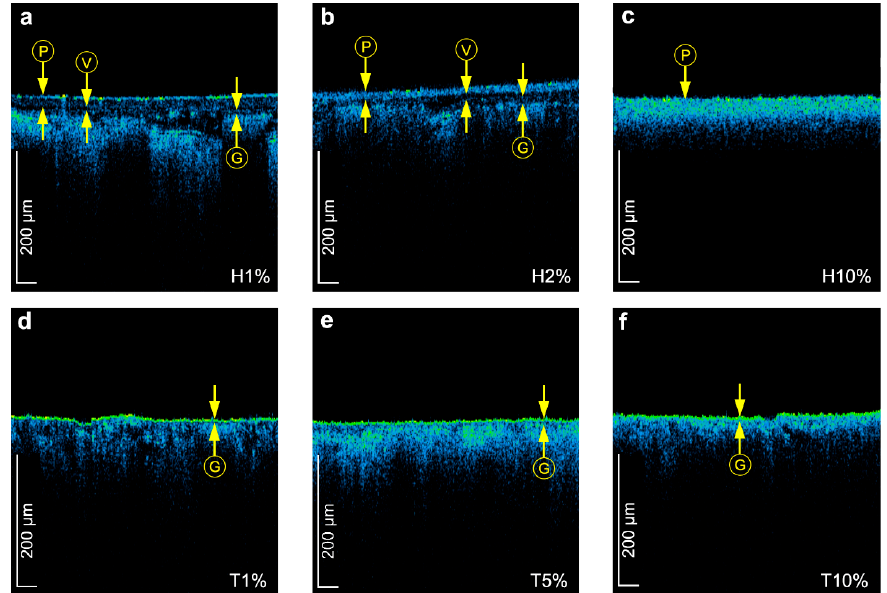
Figure 4. OCT analysis of the mock-ups: m.C ( a ), m.D ( b ), and m.F ( c ), with the paint layer